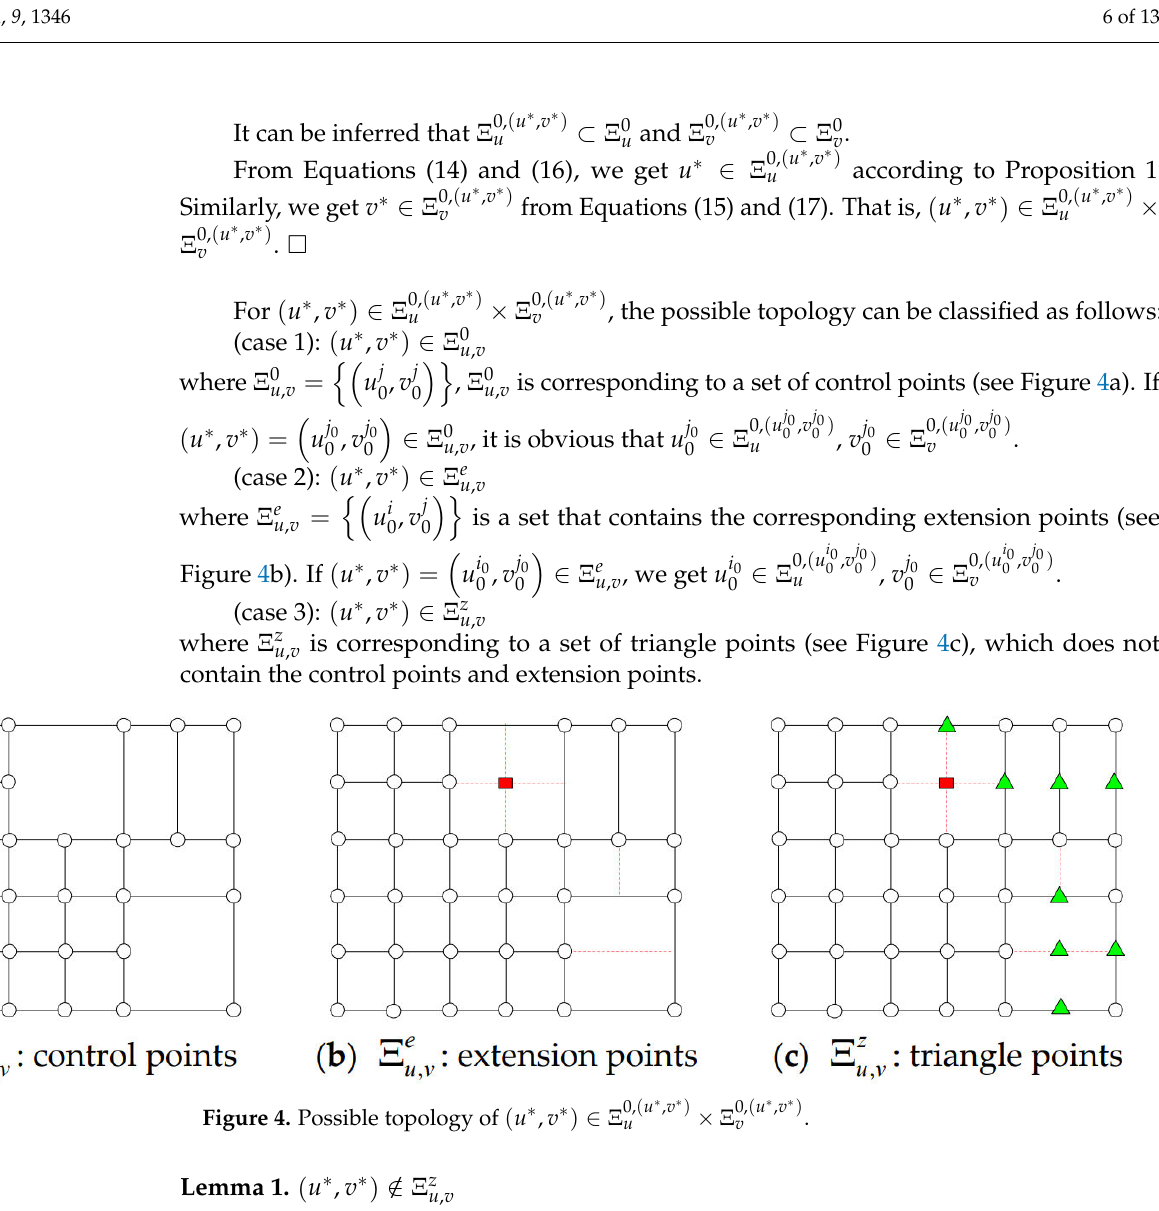
Figure 4. Possible topology of ( u ∗ , v ∗ ) ∈ Ξ 0,